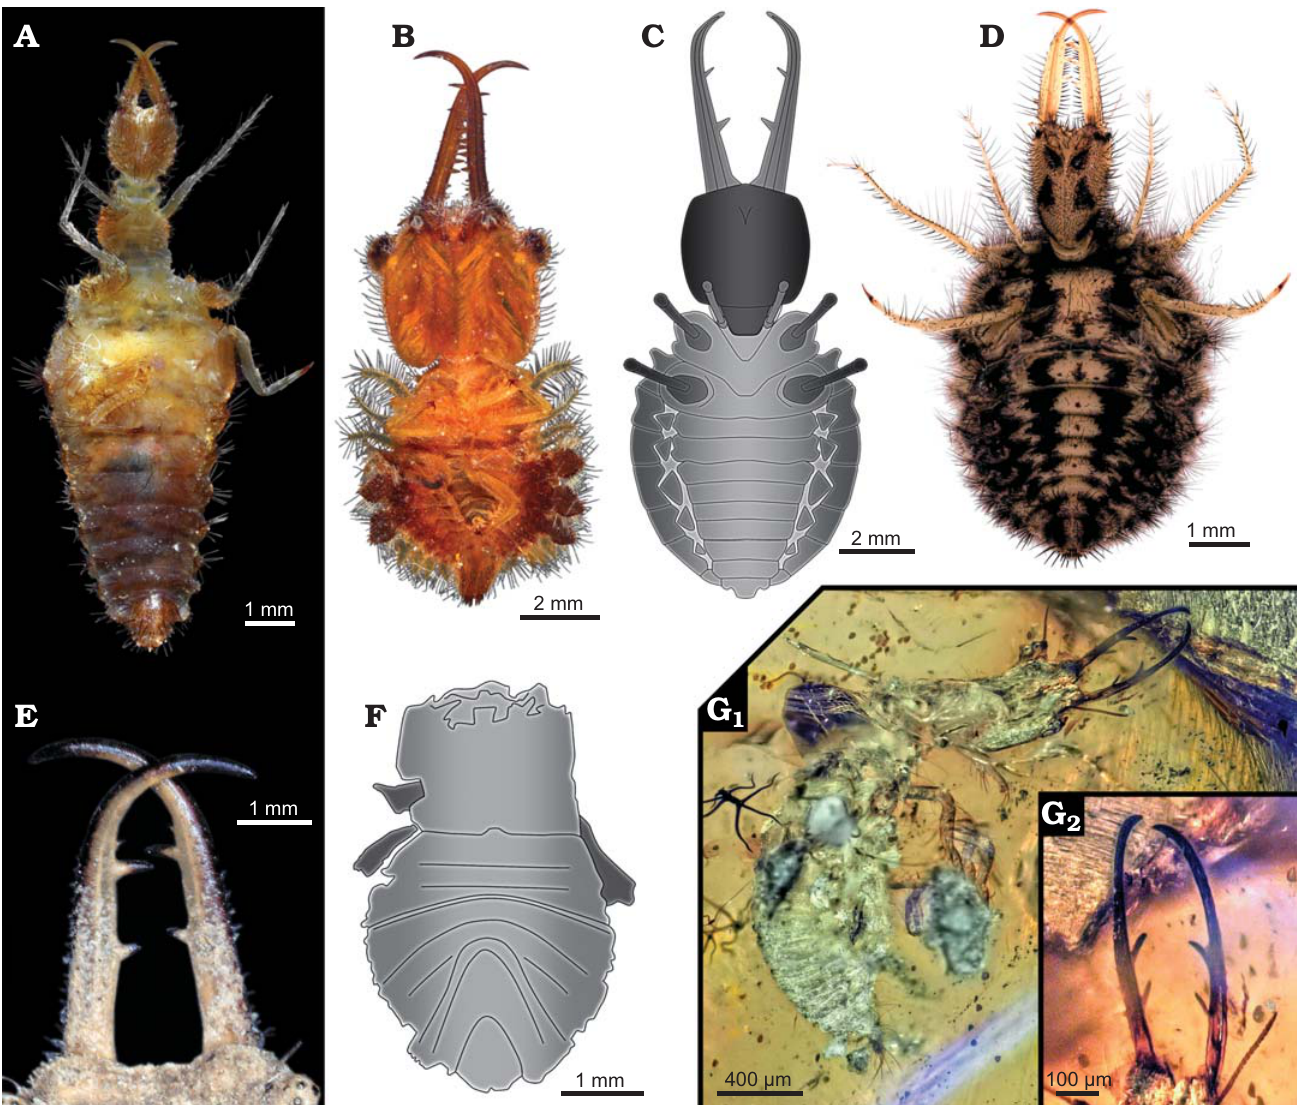
Fig. 8. Examples of extant and fossil myrmeleontiformian larvae. A . Extant Myrmeleontidae (ZMH 62891), note set off anterior trunk. B . Extant Ascalaphidae (ZMH 62880), note very round trunk. C . Drawing of MfN MB.I 2157 from Crato Formation, Aptian, Lower Cretaceous, Brazil. D . Extant Myrmeleontidae (ZSM unnumbered), note very round trunk. E . Close-up on extant myrmeleontiformian larva (ZSM unnumbered) with two prominent teeth and one very tiny tooth. F . Drawing of unnumbered specimen from Crato Formation, Aptian, Lower Cretaceous, Brazil, simplified from Rumbucher 1995. G . Larva with two prominent teeth, Burmese amber, Cenomanian, Upper Cretaceous, Myanmar (formerly collection Jörg Wunderlich under F3199_ BU_CJW, deposited in the Palaeo-Evo-Devo Research Group Collection of Arthropods, Ludwig-Maximilians-University Munich, Germany). Overview image (G 1 ), close-up on stylet region (G 2